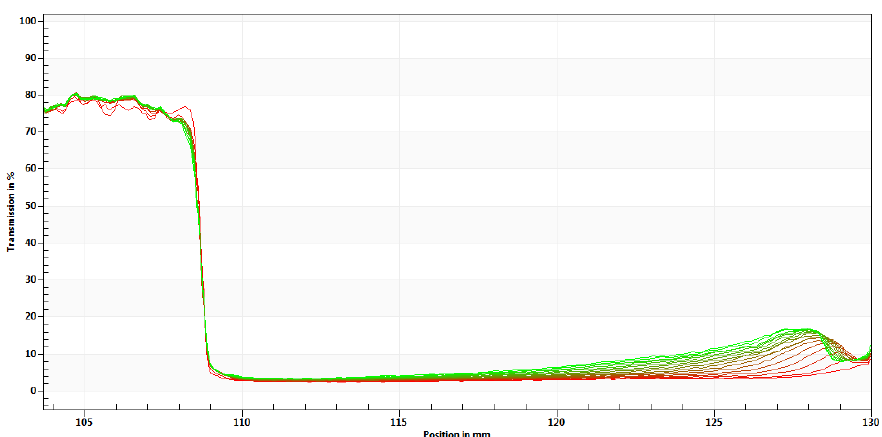
Figure A2. Physical stability of the DSI-IUHT obtained via a LUMISizer (original transmission: color lines change from red to green as time increases).